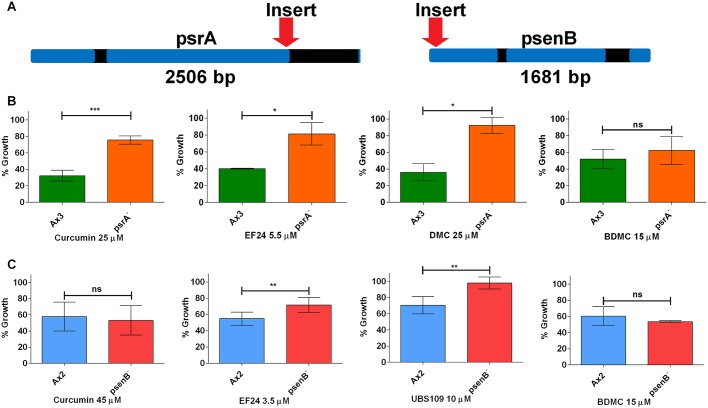
Loss of psrA and psenB genes provides partial growth resistance to curcumin or its derivatives. (A) Through screening a D. discoideum mutant library, a mutant showing resistance to curcumin was identified showing an insertion into the protein phosphatase 2A regulatory subunit gene (psrA), and a mutant showing resistance to EF24 was identified showing an insertion into the presenilin B gene (psenB) (blue exons and black introns). (B) Analysis of wild-type (Ax3) and recapitulated psrA− mutant growth rate confirmed that the psrA− mutant was resistant to curcumin, and additionally to EF24 and DMC, but not BDMC (Fig. S5). (C) Analysis of wild-type (Ax2) and recapitulated psenB− mutant growth rate showed that PsenB was not resistant to curcumin, but showed confirmed resistance to EF24, in addition to UBS109 (Fig. S6). Data are presented as mean±s.e.m. of triplicate experiments. *P<0.05; **P<0.01; ***P<0.001; ns, nonsignificant.